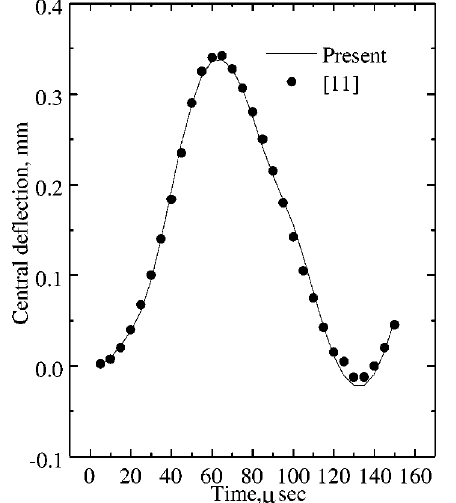
Fig. 6. Central deflection versus time for a 0 (cid:14) = 90 (cid:14) = 0 (cid:14) square clamped laminated plate with suddenly applied pulse loading (4 (cid:2) 4 mesh).